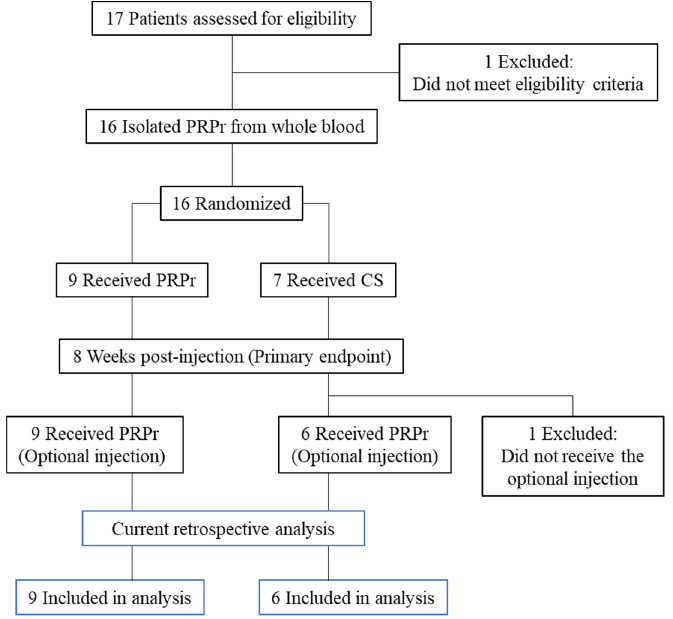
Figure 1. Flowchart of patients. Patients received an intradiscal injection of either the platelet-rich plasma releasate (PRPr) or corticosteroids (CS).